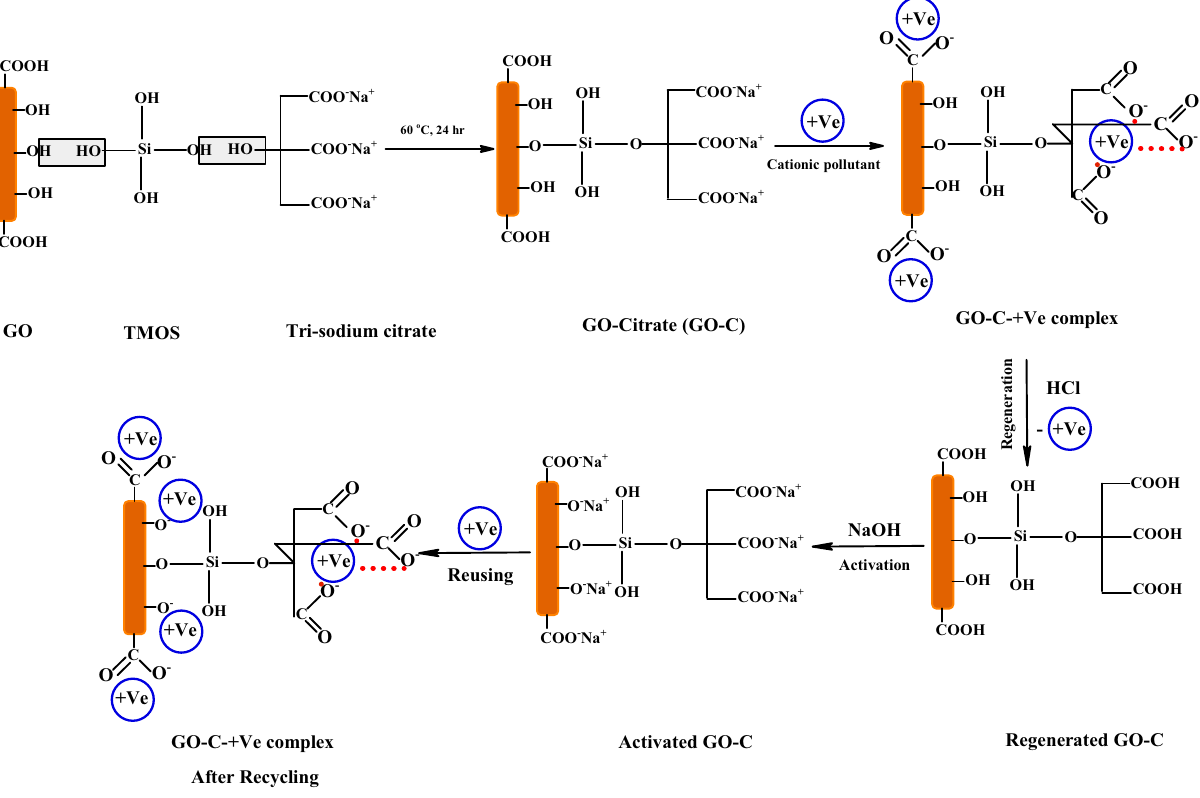
Figure 1. GO–C composite preparation, adsorption and regeneration/reused